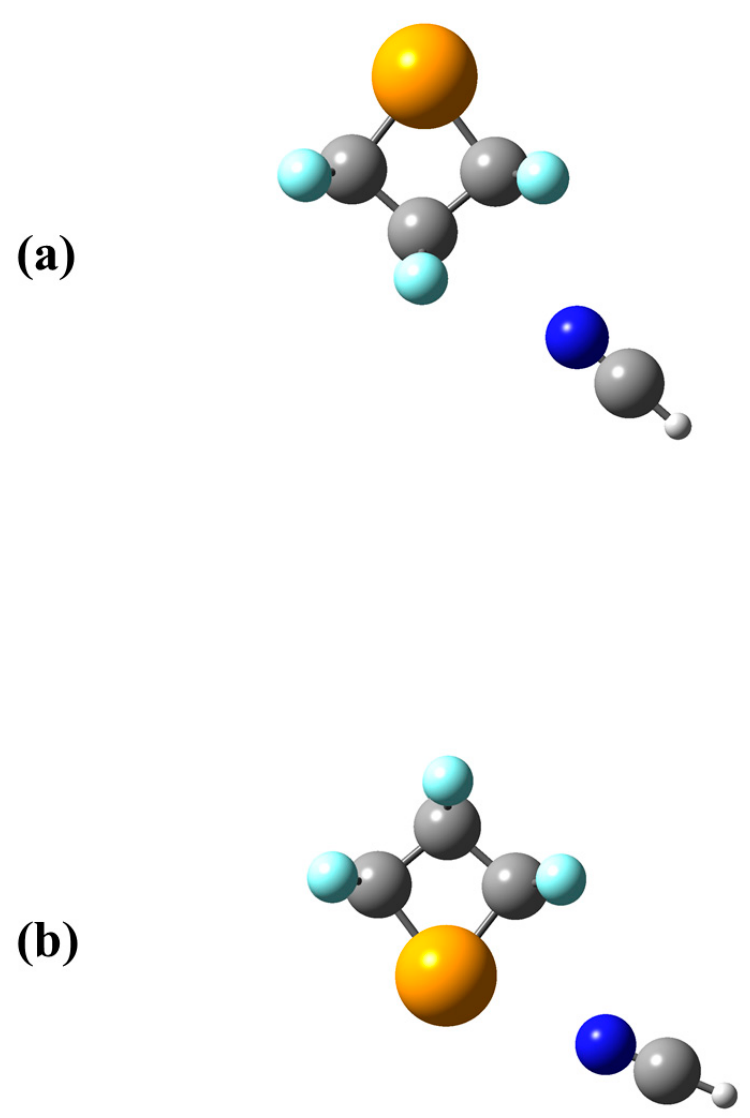
Figure 5. Computed structures of products of interactions between heterocycle 1 and HCN. Colors of atoms: gray, carbon; light blue, fluorine; white, hydrogen; blue, nitrogen; gold, selenium. ( a ) The nitrogen is positioned near the center of a C–C bond; in the other, ( b ) The nitrogen is near the center of a Se–C bond.